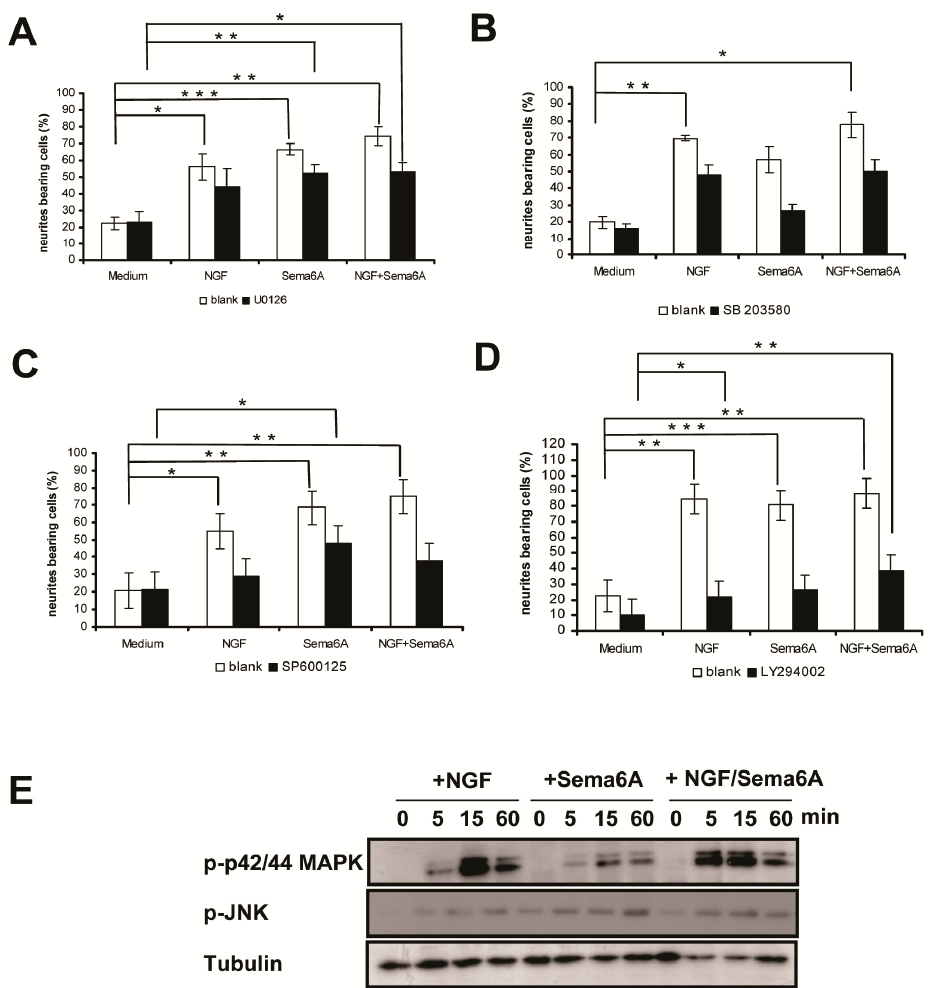
Figure 2. Mitogen-activated protein kinases (MAPKs) and phosphatidylinositol-3-kinase (PI3K) signaling were necessary for Sema6A-stimulated NGF-induced neurite outgrowth in PC12 cells. PC12 cells were pretreated for 30 min with (black bar) or without (white bar) 10 µm p42/44 MAPK inhibitor U0126 ( A ); 10 µm p38 MAPK inhibitor SB203580 ( B ); 50 µm c-jun NH 2 -terminal kinase (JNK) MAPK inhibitor SP600125 ( C ) or 50 µm PI3K inhibitor LY294002 ( D ) prior to 50 ng/mL NGF and/or 1 nM Sema6A. Neurite outgrowth was quantified by counting PC12 cells bearing at least one neurite with a length longer than twice the cell body diameter. Each value is the mean ± S.E. for >100 PC12 cells sampled from three independent experiments. * p < 0.05; ** p < 0.01; *** p < 0.001, respectively, by Student’s t test; ( E ) Time course experiment of MAPK phosphorylation in PC12 cells after being treated with 50 ng/mL NGF and/or 1 nM Sema6A. PC12 cells were treated for 5, 15, or 60 min with NGF, Sema6A or NGF + Sema6A. At the indicated times, phospho-p42/p44 MAPK (p-p42/p44 MAPK) or phospho-JNK (p-JNK) were detected by immunoblotting with antibodies recognizing the corresponding phosphorylated proteins.